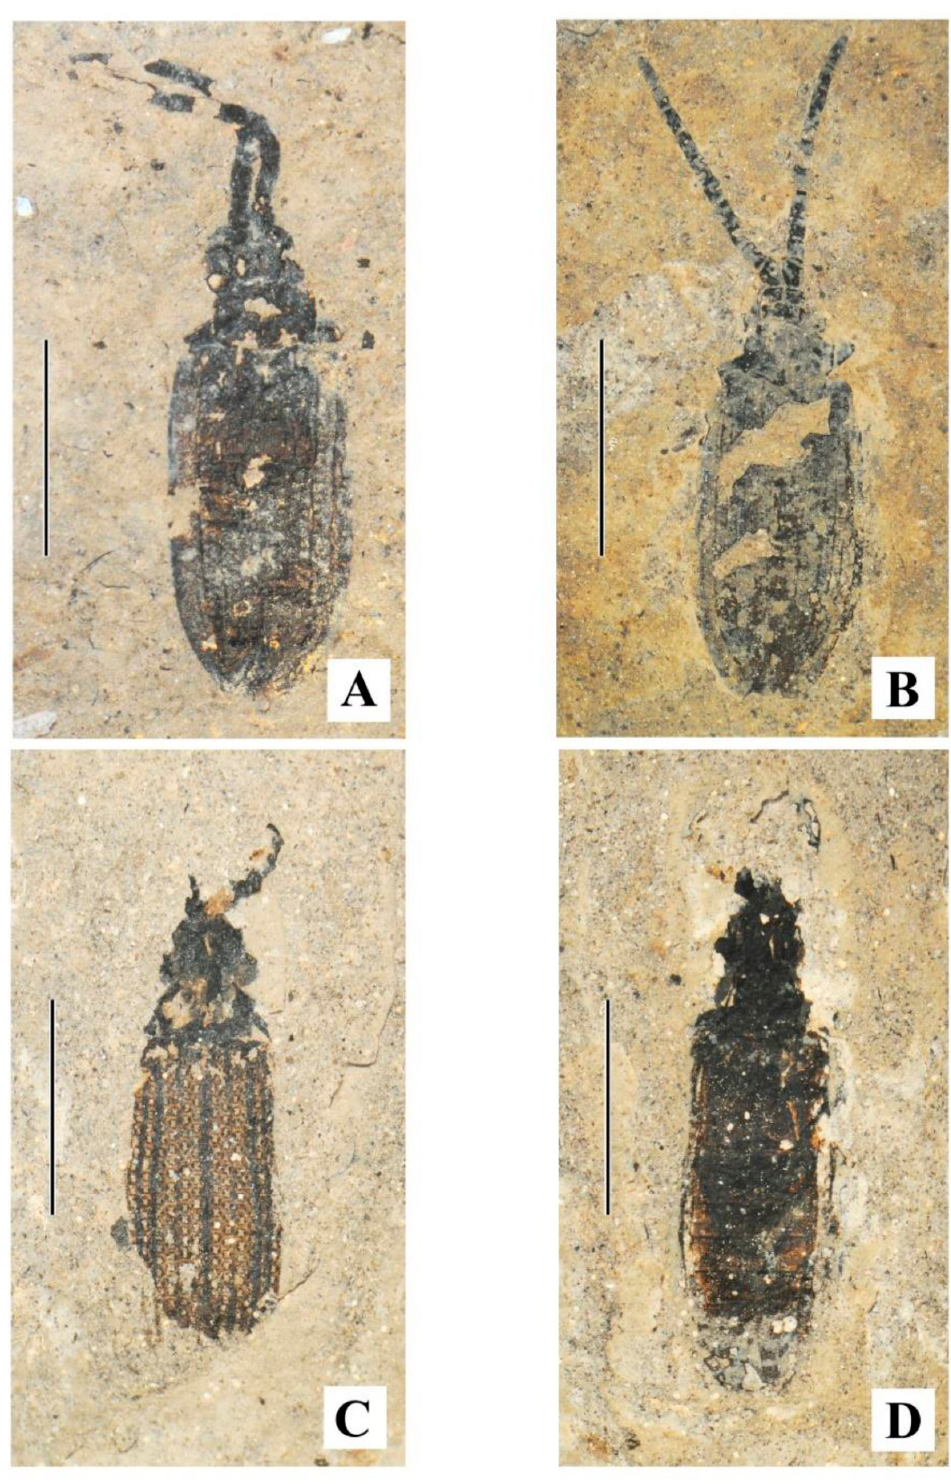
Figure 22. Cupedinae (Cupedidae). Species of Cupes from Messel (Palaeogene, Eocene, Lutetian Hessen (Grube Messel Pit)): A – B — Cupes nabozhenkoi sp. nov. : A —holotype, MeI4010-01 (SFNFM), scale bar = 2.6 mm; original. B —paratype, MeI11220-01 (SFNFM), scale bar = 6.2 mm; original. C–D — Cupes wedmannae sp. nov. , holotype, MeI4386A, part and MeI4386B, counterpart (SFNFM), scale bar for C = 4.1 mm, scale bar for D = 2.6 mm; original.